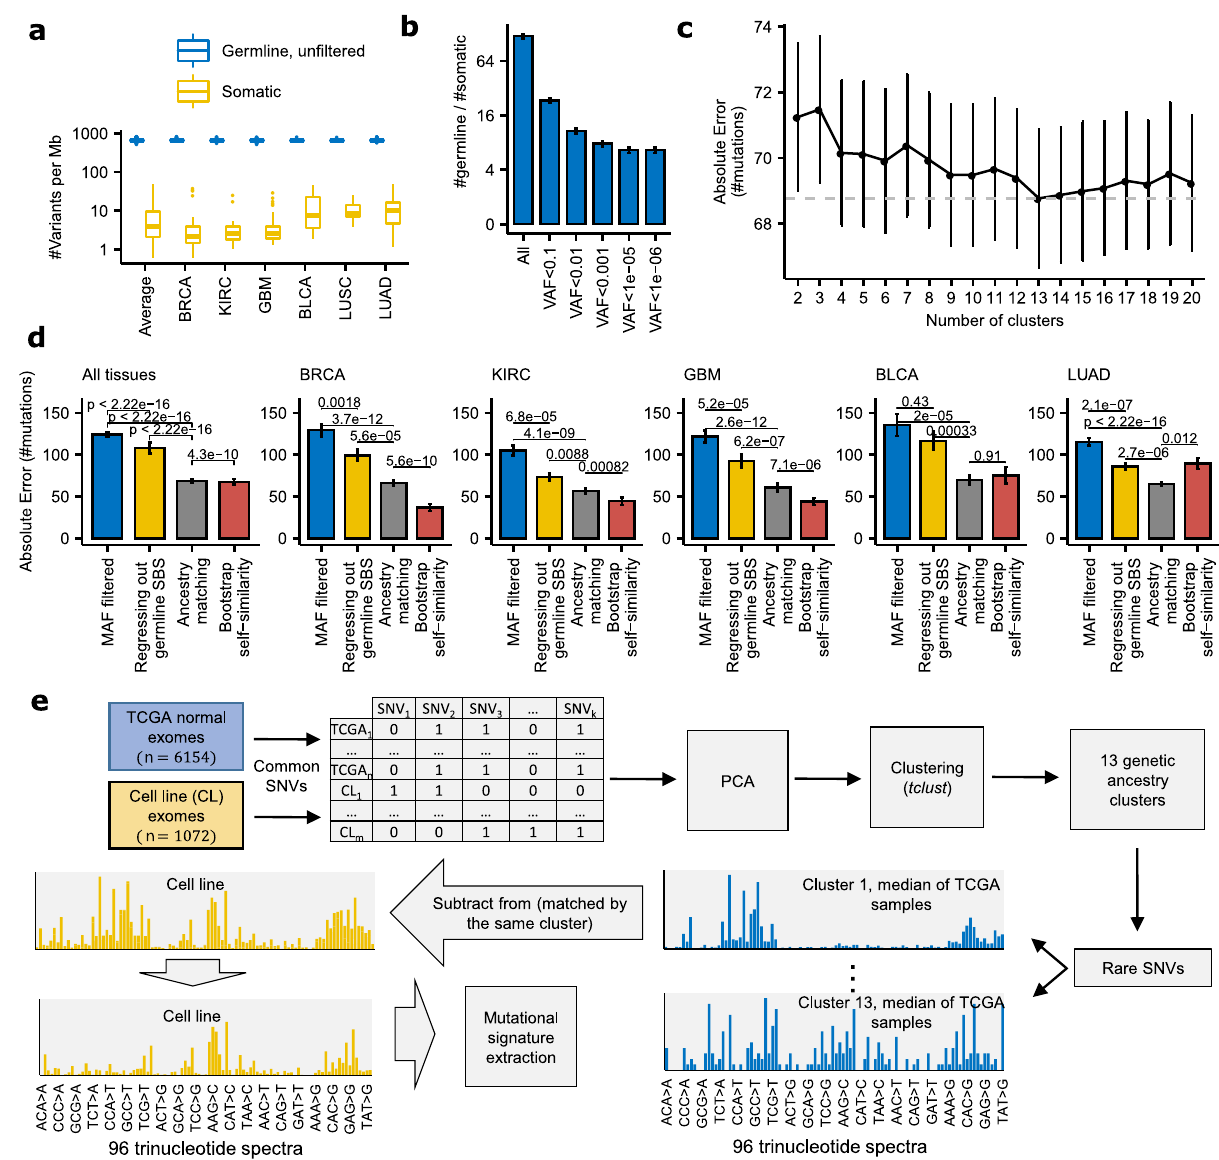
Fig. 1 Evaluation of the ancestry-matching method to infer somatic mutation spectra on exomes without a matched normal control. a , b Germline variants greatly outnumber somatic mutations in exomes of various tumor types ( n = 52 BRCA, 33 KIRC, 53 GBM, 19 BLCA, 15 LUSC, and 67 LUAD cancer exomes) ( a ), also after attempting to fi lter out germline variants according to the minor allele frequency (MAF) of variants listed in the gnomAD database ( n = 450 cancer exomes) ( b ). The center line of box plots denotes medians of data points and the box hinges correspond to the 1st and 3rd quartiles, while whiskers extend to 1.5× IQR from the hinges. Data points beyond the end of the whiskers are shown individually. c Error between the real somatic 96 tri- nucleotide pro fi les and the pro fi les obtained with the ancestry-matching procedure, after various numbers of clusters (based on principal components of common germline variants; see Methods) are considered ( n = 450 cancer exomes). d Comparison of the ancestry-matching method (with the number of clusters set to 13), the baseline procedure (variant fi ltering by population MAF<0.001%), regressing out mutational signatures reported as related to germline variants (signatures 1 and 5, and SNP signature 31,110 ), and the error expected by chance (estimated by bootstrapping mutations). P -values by two- sided Wilcoxon rank-sum test ( n = 450 cancer exomes). e A schematic representation of the ‘ ancestry matching ’ procedure. For compactness, the X-axes on the mutation spectra illustrations list only a subset of mutation types. PCA, principal components analysis. Error bars in panels b – d are the standard error of the mean. Source data are provided as a Source Data fi